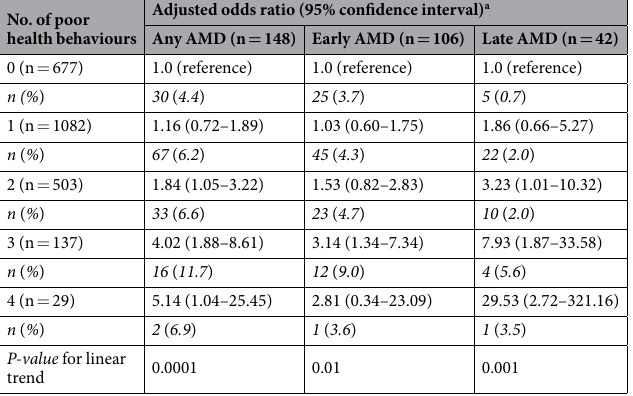
Table 3. Collective health behaviours and prevalence of AMD in the Blue Mountains Eye Study (n = 2428). a Adjusted for age, sex, white cell count, and fish consumption.